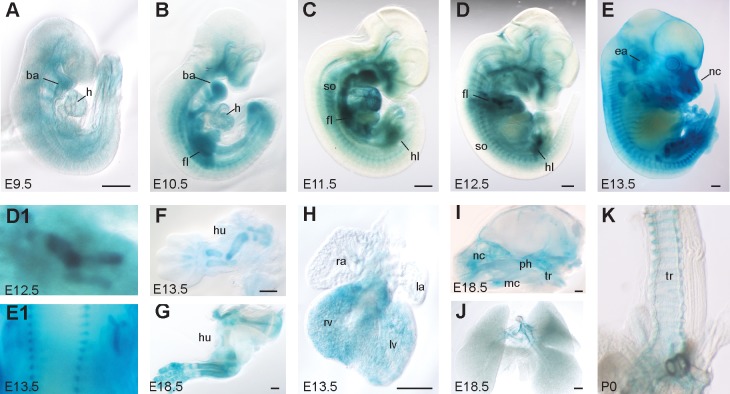
ASAP1 is strongly expressed in the developing skeleton, heart and trachea.X-Gal staining of Asap1GT embryos at E9.5 (A), E10.5 (B), E11.5 (C), E12.5 (D), E13.5 (E). Enlarged images of the developing fore limb of an E12.5 embryo (D1) and the spine of an E13.5 embyro (E1). (F and G) Staining of prepared forelimbs of E13.5 and E18.5 embryos. (H) β-geo reporter expression in the E13.5 heart. (I and J) β-geo reporter expression in the skull and lung at E18.5. (K) β-geo reporter expression in the trachea at P0. Scale bars: 0.5 mm. Abbreviations: ba, branchial arch; ea, ear; fl, fore limb; h, heart; hl, hind limb; hu, humerus; la, left atrium; lv, left ventricle; nc, nasal cavity; mc, meckel’s cartilage; ph, pharynx; ra, right atrium; rv, right ventricle; so, somites; tr, trachea.